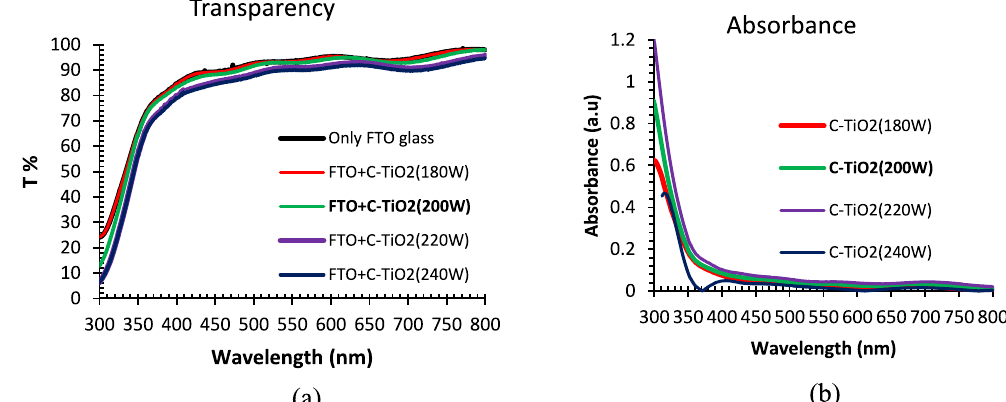
Fig. 6. Optical properties of C-TiO 2 coated FTO glass (a) transparency of the FTO glass without and with a C-TiO 2 prepared with different sputtering powers (b) absorbance spectrum of C-TiO 2 sputtered with different powers.